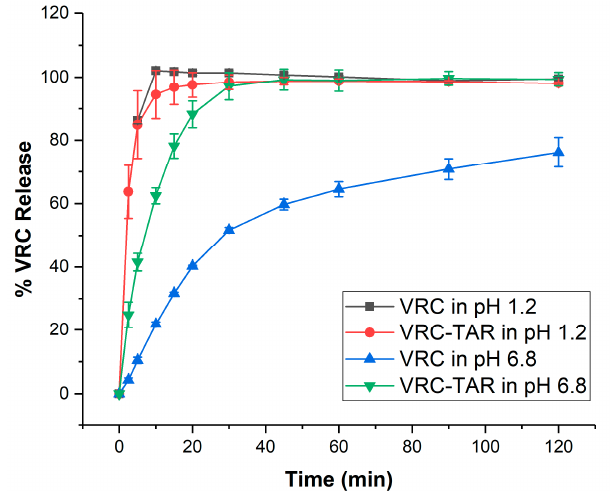
Figure 10. Dissolution profiles of the VRC-TAR cocrystal system at pH 1.2 and pH 6.8.